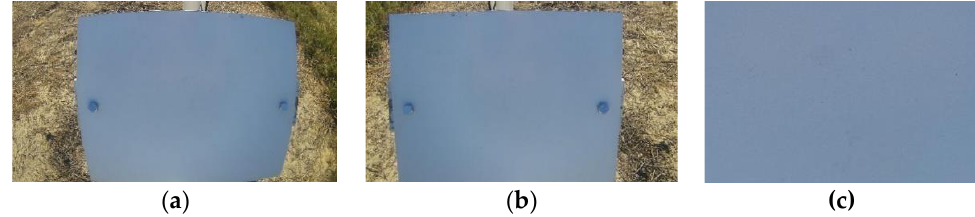
Figure 7. Example images of the reference surface: ( a ) the original image of the reference surface, ( b ) image with corrected barrel distortion, and ( c ) cropped image, which represents a 7.6 × 5 cm surface.